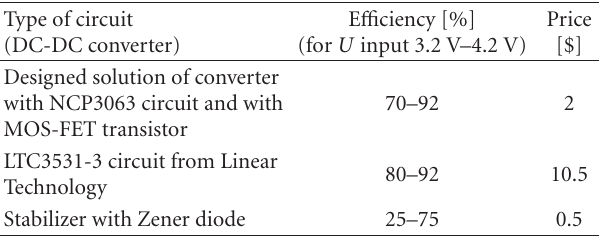
Table 1: Comparison of various converter